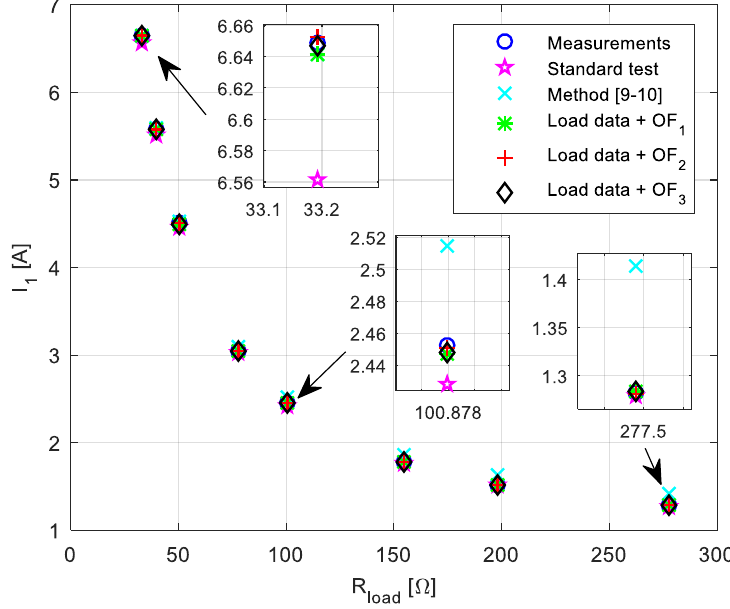
Figure 5. Primary current versus load resistance referred to the primary side characteristics.